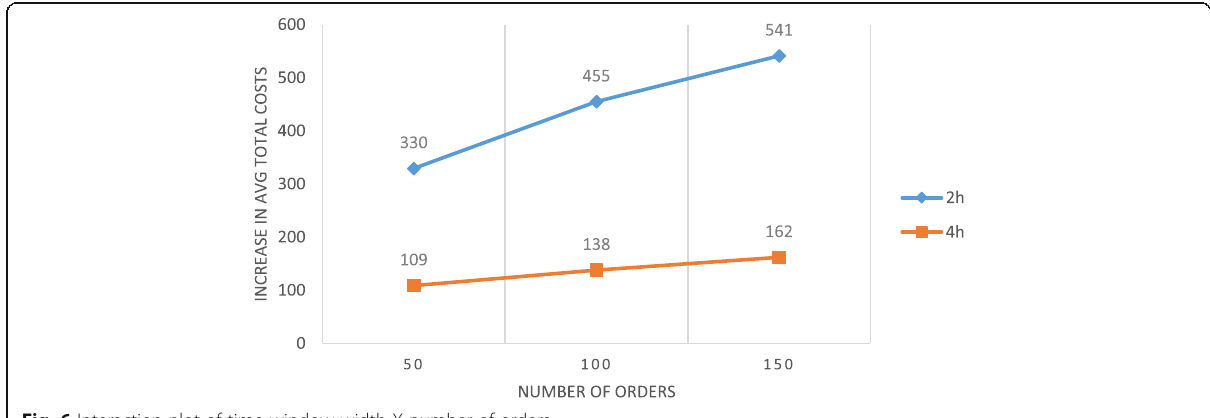
Fig. 6 Interaction plot of time window width X number of orders